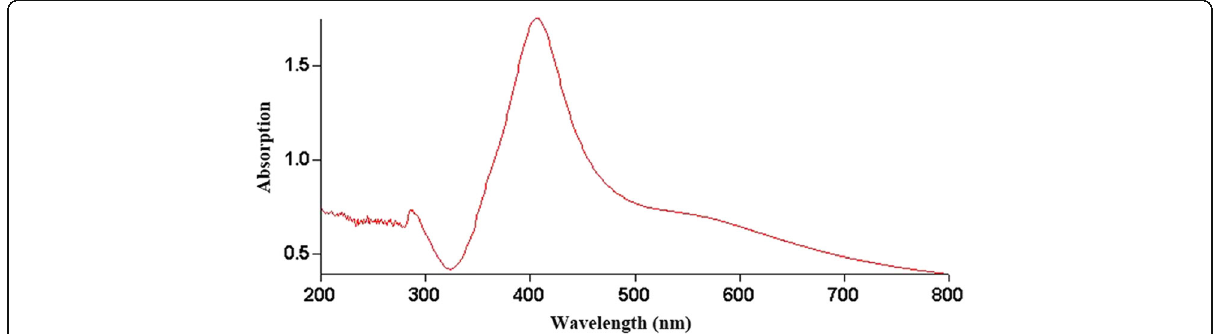
Fig. 1 UV-visible spectrum of synthesized silver